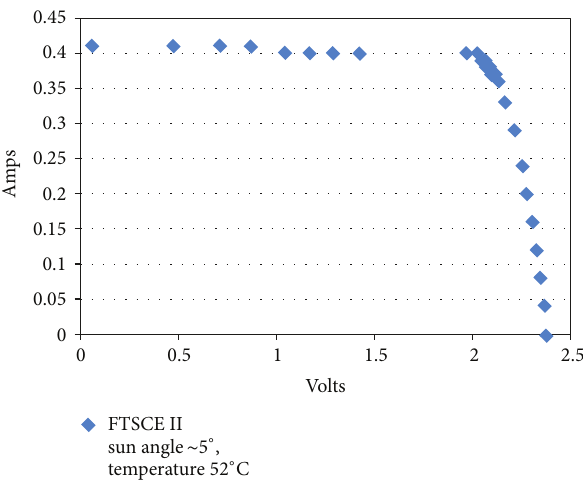
Figure 8: Typical I-V (current versus voltage) curve for a solar cell as measured by the Forward Technology Solar Cell Experiment II (FTSCE II).